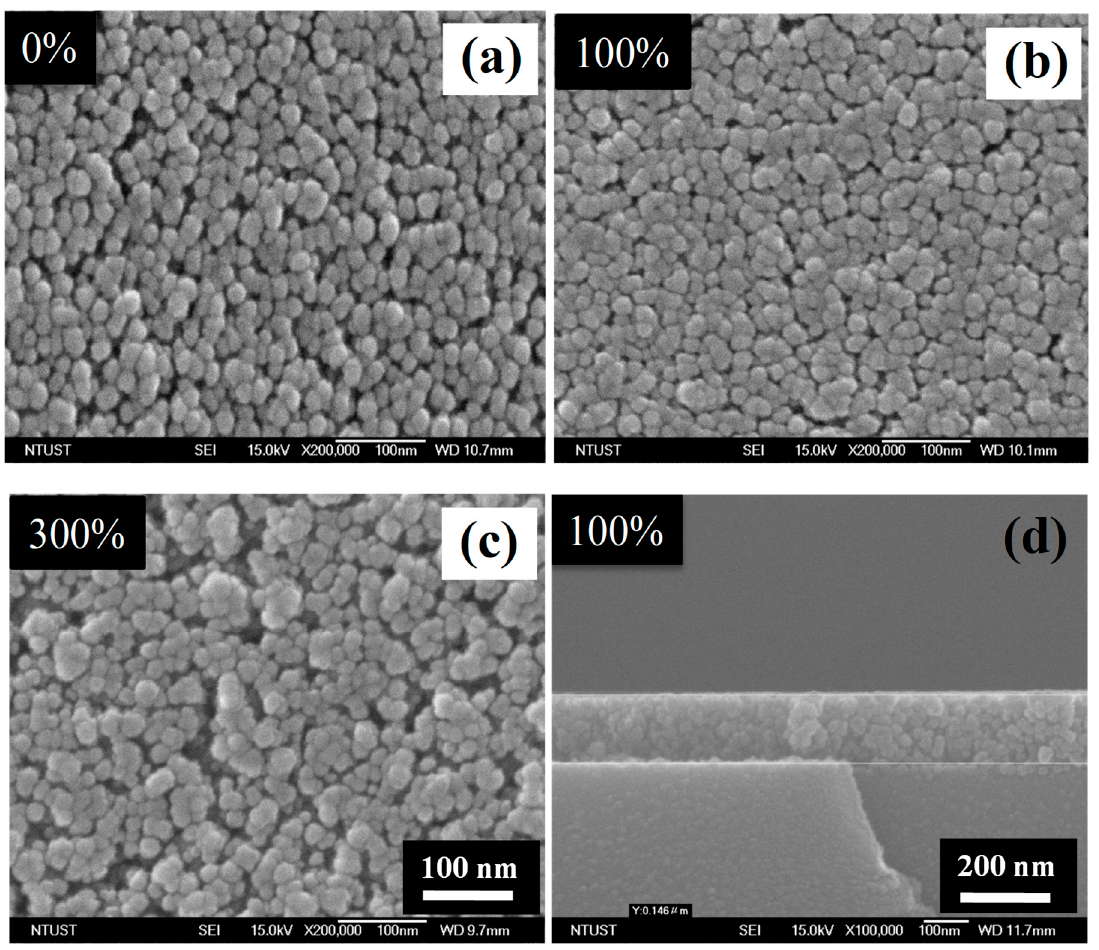
Figure 6. SEM images of top-view of C–TiO 2 films synthesized in ( a ) 0%, ( b ) 100% and ( c ) 300% glucose aqueous solutions after sintered at 300 °C, respectively. ( d ) The cross-section image of ( b ).